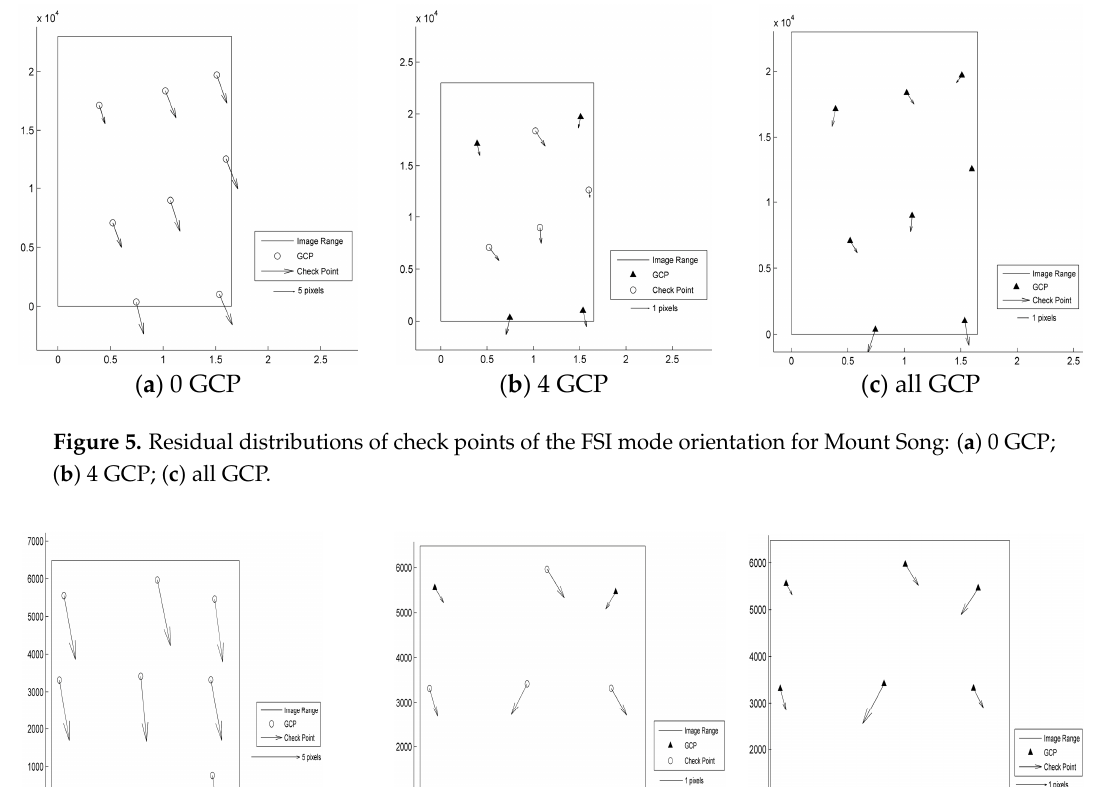
( c ) all GCP Figure 7. Residual distributions of check points of the SS mode orientation for Mount Song: ( a ) 0 GCP; ( b ) 4 GCP; ( c ) all GCP. Using DEM data of the control data source, orientation parameters are obtained for the case of four corner control points and for each ortho-rectification image. For the ortho-image, the check points are checked again to verify the geometric accuracy. The results are shown in Table 4. The single image ortho-rectification accuracy results and orientation precision are almost consistent, indicating that a high-precision DEM can effectively eliminate the differences caused by projection of the terrain. The accuracy of GF-3 was compared with that of equivalent satellites with similar payload types around the world, and the results are shown in Table 5. In terms of both resolution and geometric positioning accuracy, the GF-3 satellite compares well with other satellites such as TerraSAR-X, RADARSAT-2, and ERS. Table 4. Table of ortho-rectification accuracy comparison among the five GF-3 satellite imaging modes . Image Mode